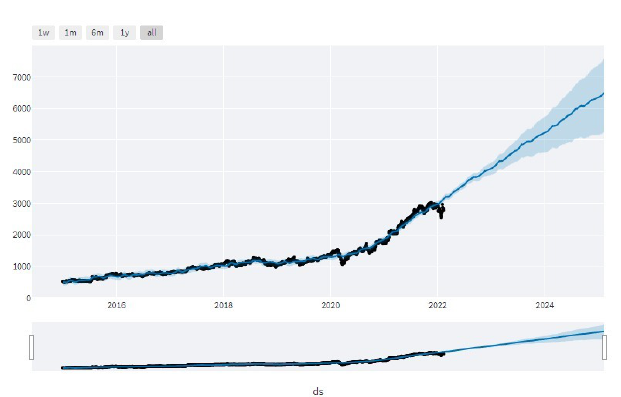
Figure 3. Forecast of the stock using